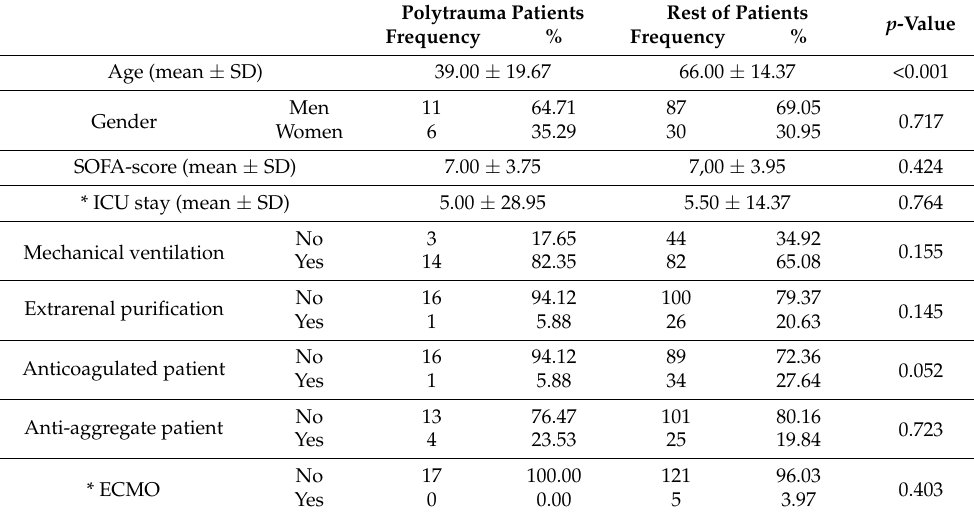
Table 3. Demographic and Clinical Characteristics on transfused